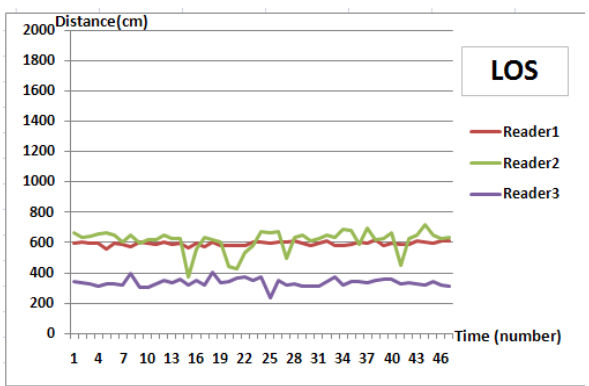
Fig. 6. Tracking performance under a LOS